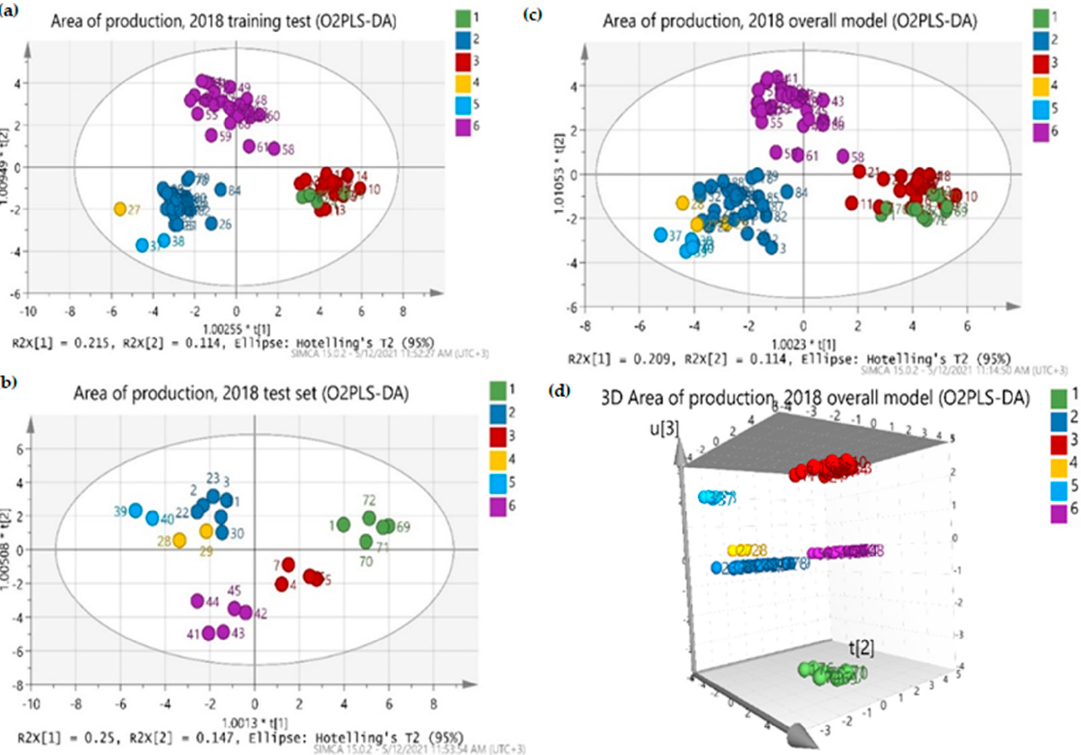
Figure 8. Score scatterplots for the wine samples of 2018 classified regarding area of production (i.e., 1: Naousa, 2: Attika, 3: Nemea, 4: Santorini, 5: Samos, and 6: Arkadia), where ( a ) training set, ( b ) test set, ( c ) overall model 2D, and ( d ) overall model 3D). Table 10. The R2X(cum), R2Y(cum), and Q2(cum) scores of classifications for the wine samples between 2017 to 2018 regarding area of production by O2PLS-DA.